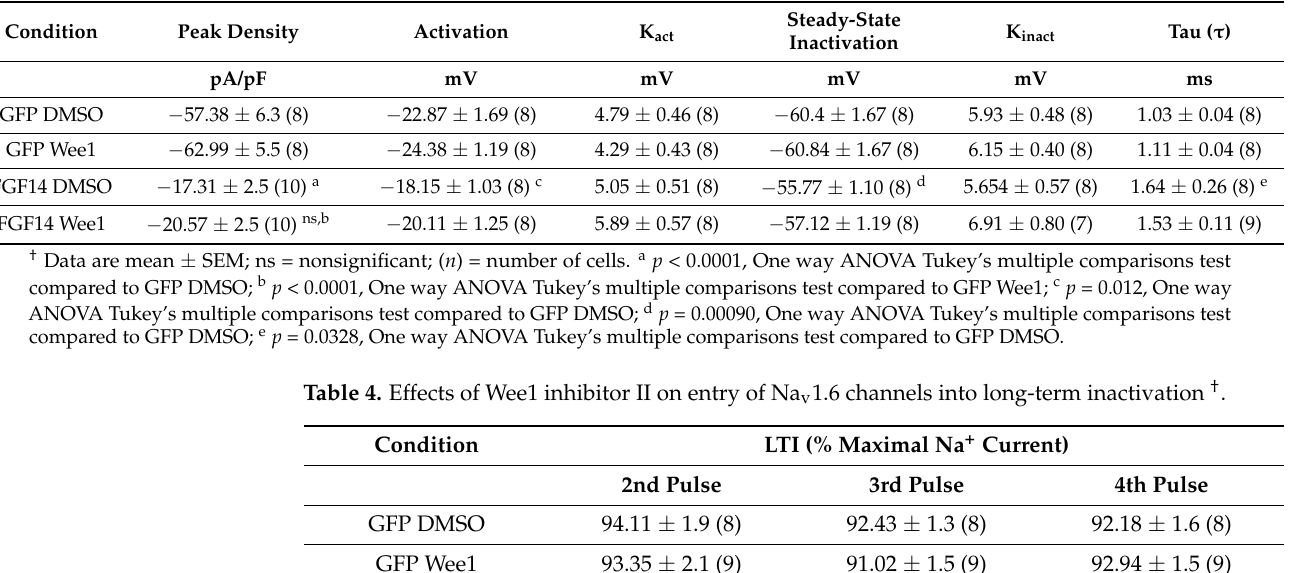
Table 3. Effects of pharmacological inhibition of Wee1 kinase on Na v 1.6-mediated currents † .